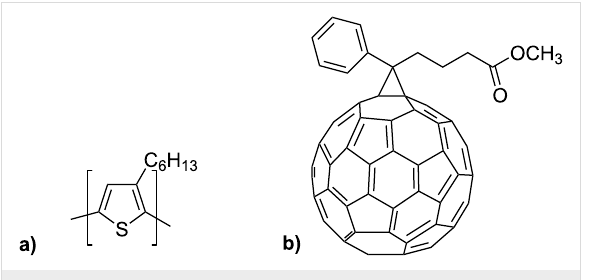
Figure 1: Structures of (a) P3HT and (b) PCBM.